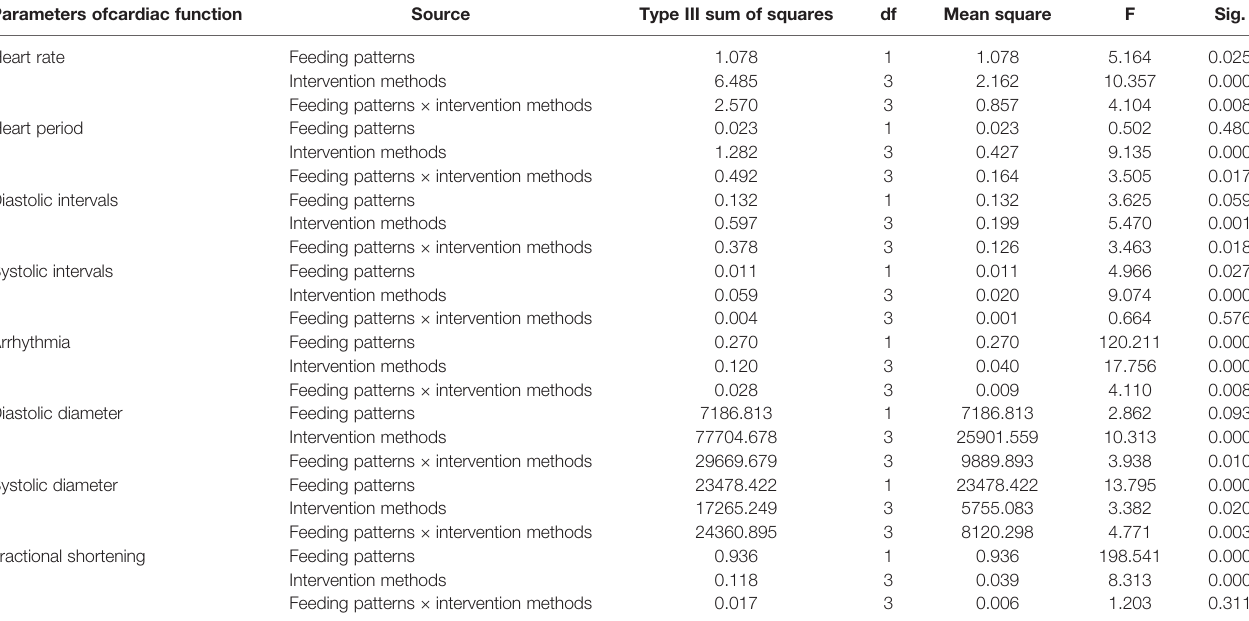
TABLE 1 | Multi-factor analysis of variance of TAG levels. Parameters ofcardiac function Type III sum of